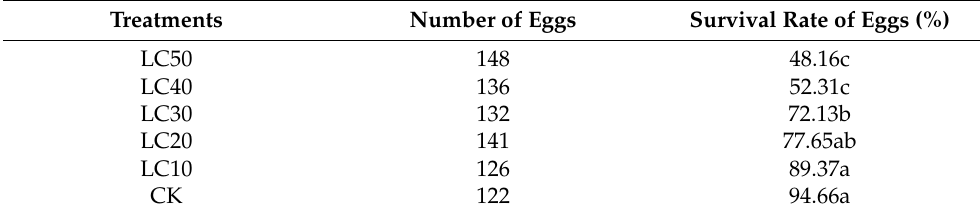
Table 4. Percent survival of eggs and larval survival rate of T. cinnabarinus eggs treated with sublethal concentrations of